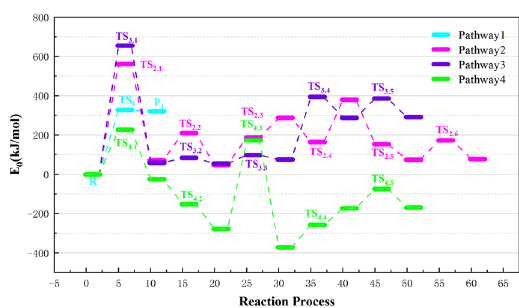
Figure 9. Reaction energy barrier diagram of pathway 1–4.